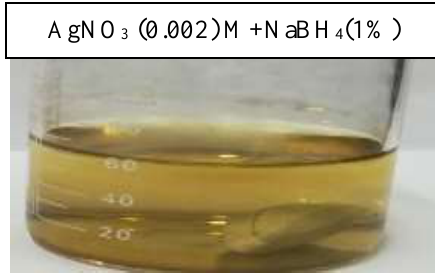
Figure 2: Silver nanoparticles before adding stabilizing agent.